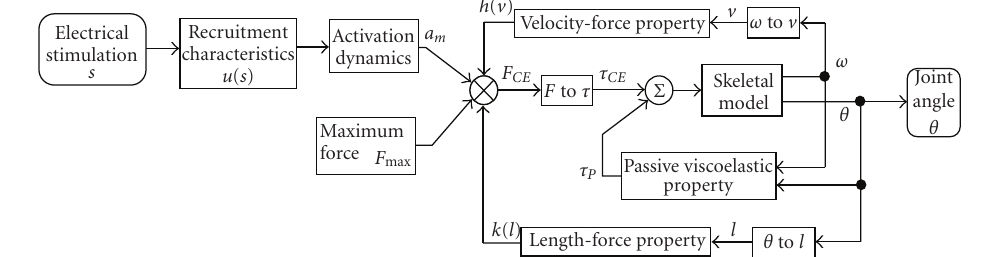
Figure 13: Outline of the musculoskeletal model for FES.